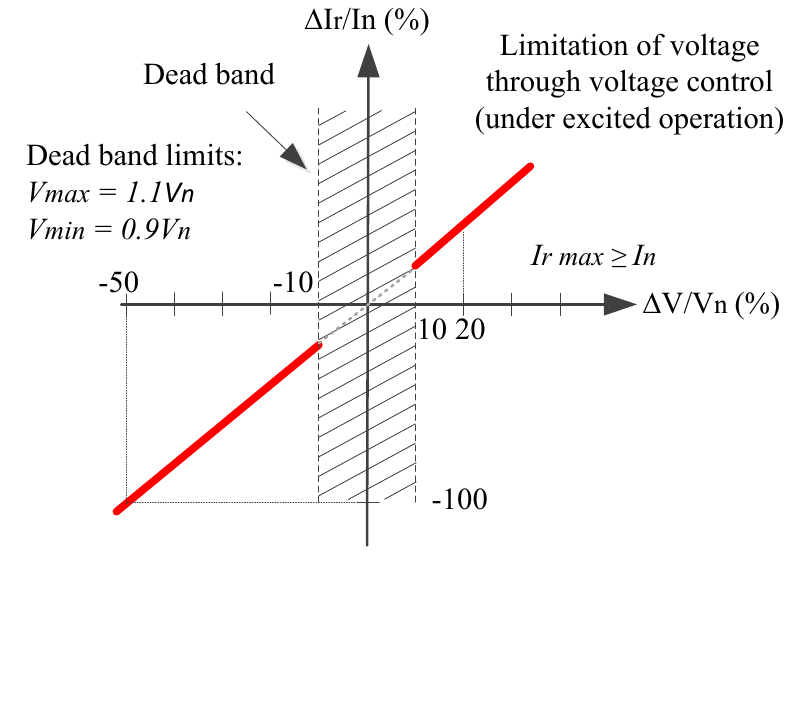
Figure 3. Reactive output current under disturbances according to the German grid code ( V n , nominal voltage; V , instantaneous voltage during the disturbance; I n , nominal current; I r , reactive